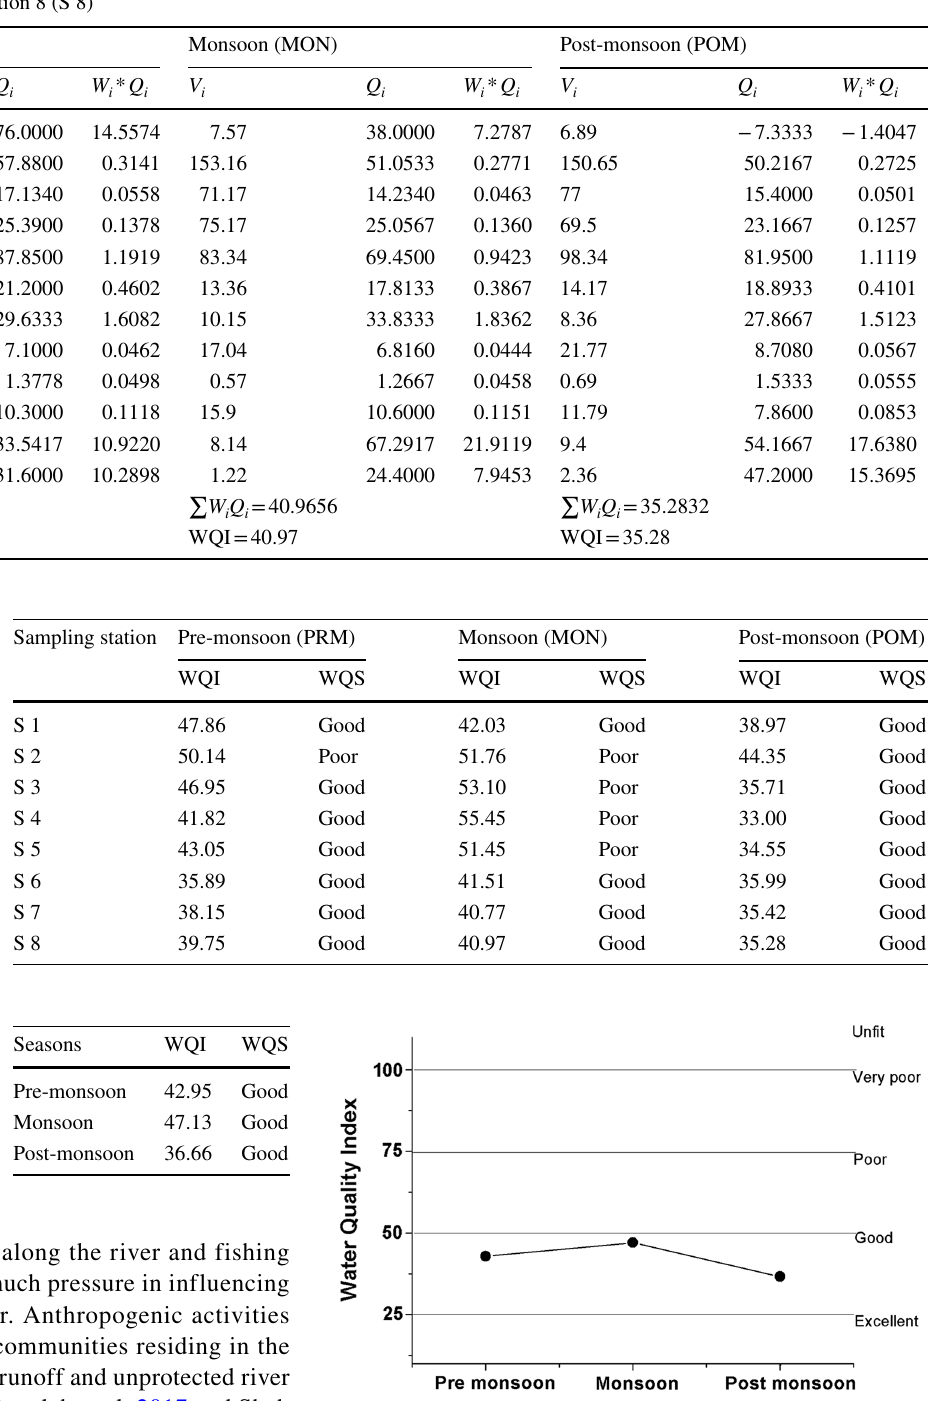
Fig. 3 WQI rating of Doyang River in various